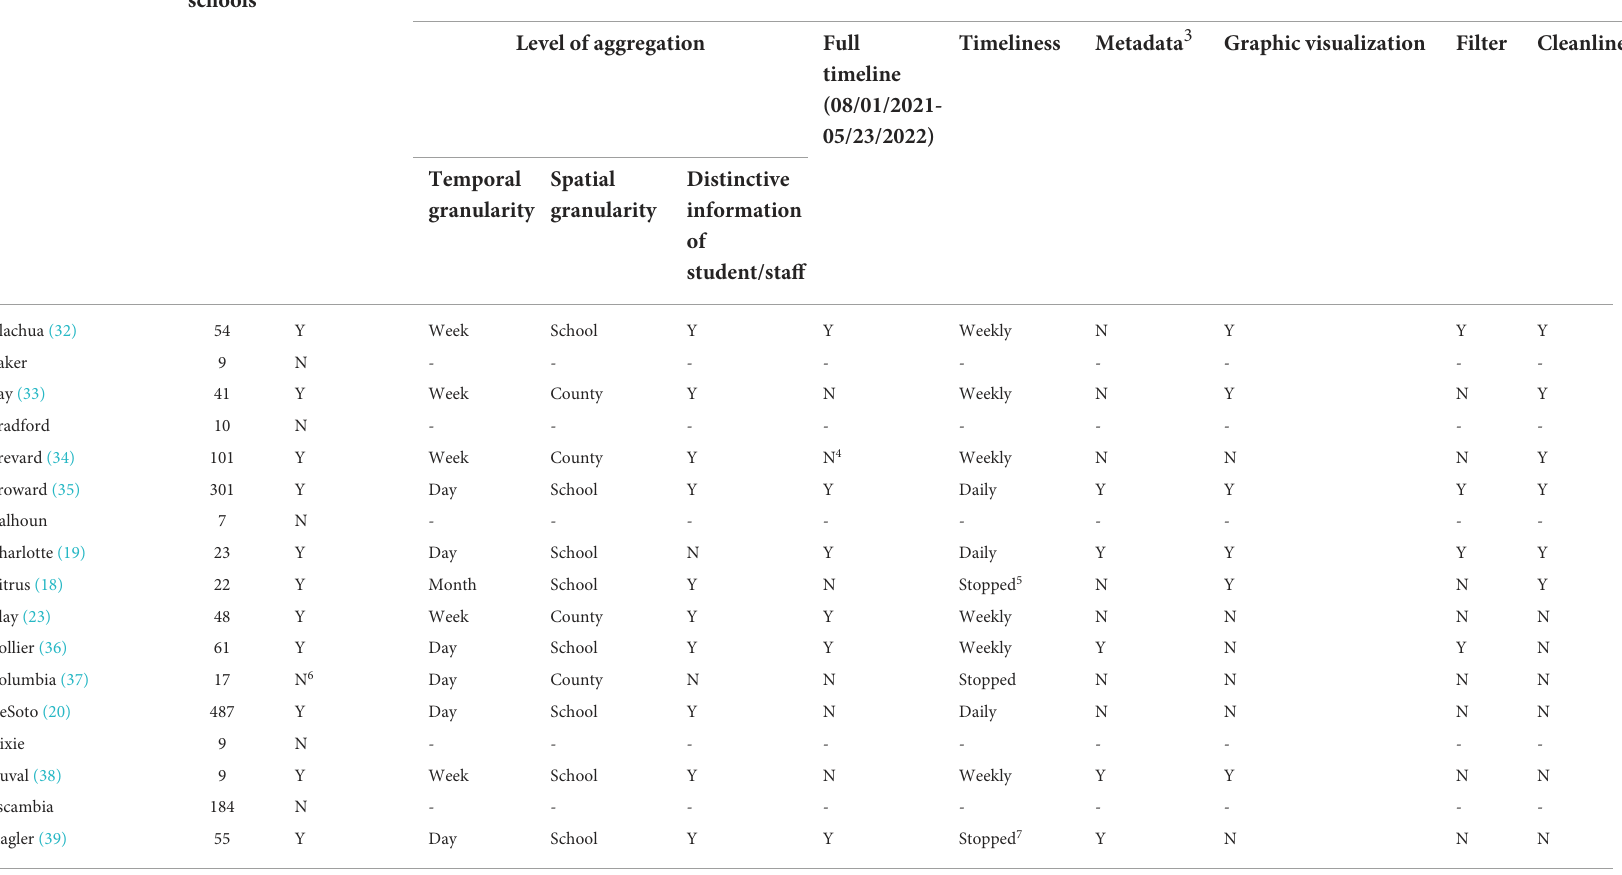
TABLE 1 Public dashboards of COVID-19 cases in the florida public school system 1